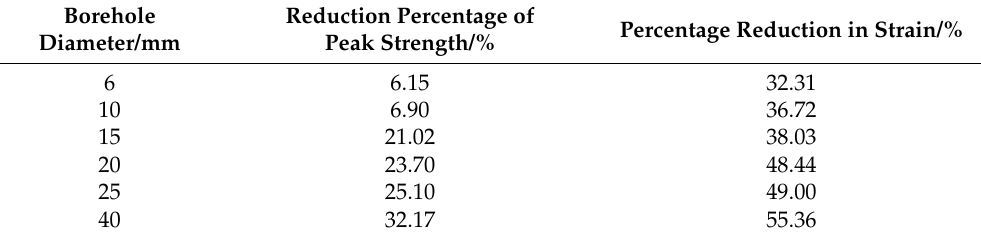
Figure 2. ( a ) is the peak strength of the test block under different pore sizes, and ( b ) is the stress–strain and pre-peak cumulative strain energy curve. Table 2. Peak intensity and strain value decrease by percentage at peak intensity.